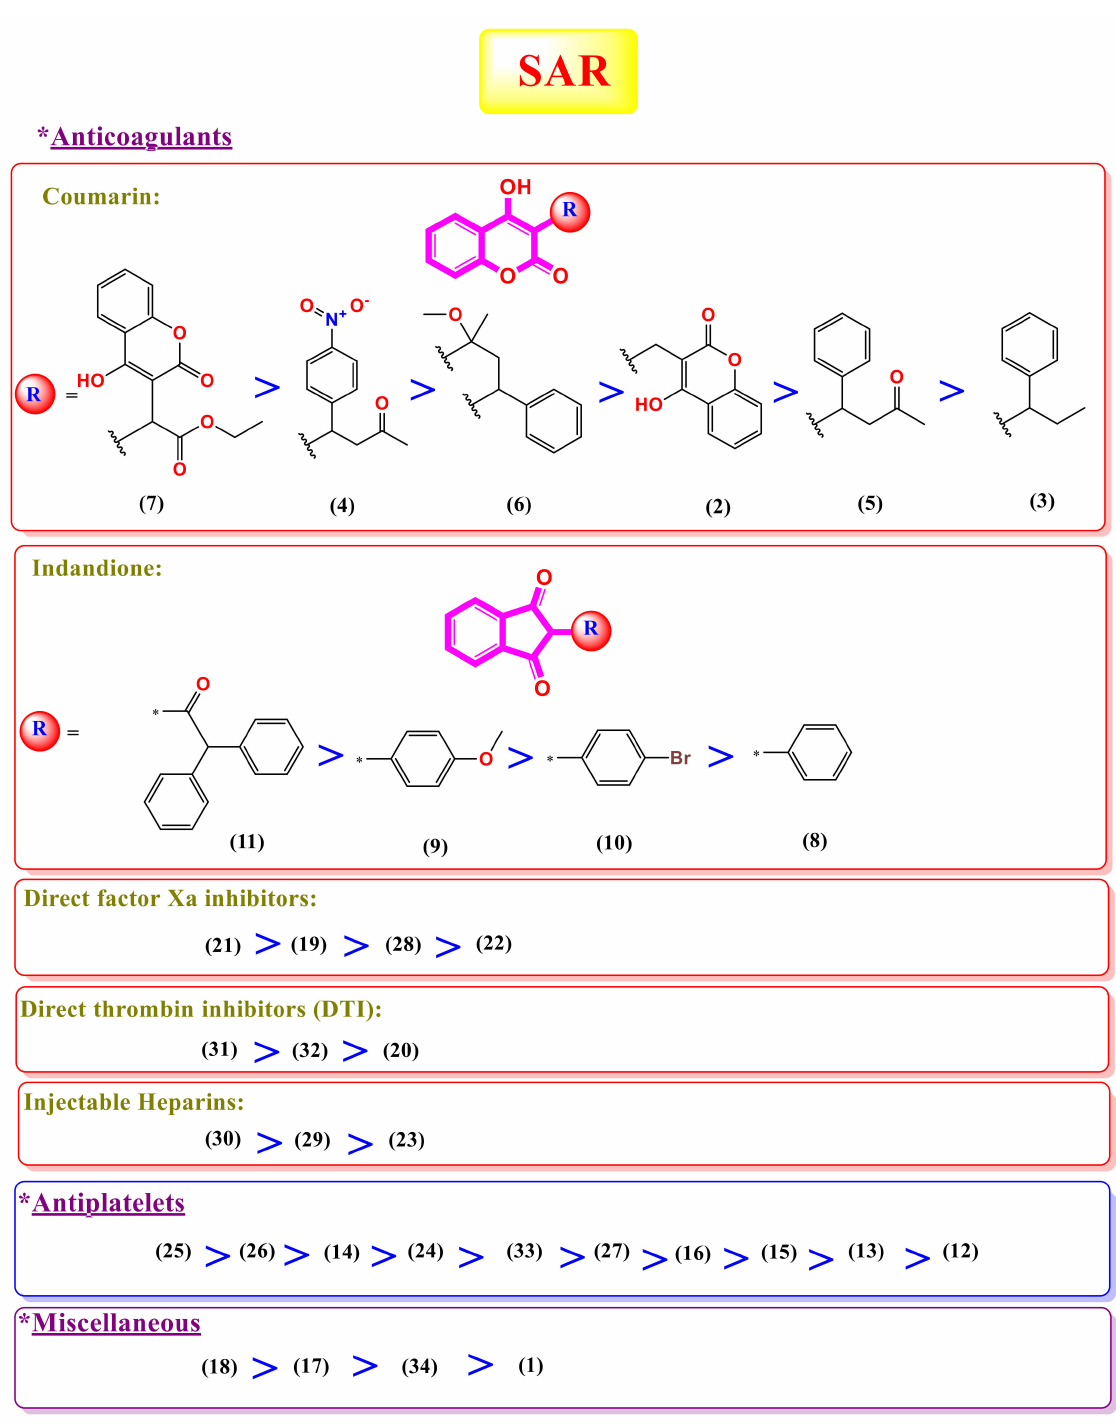
Figure 11. SAR study of the examined anticoagulant drugs towards